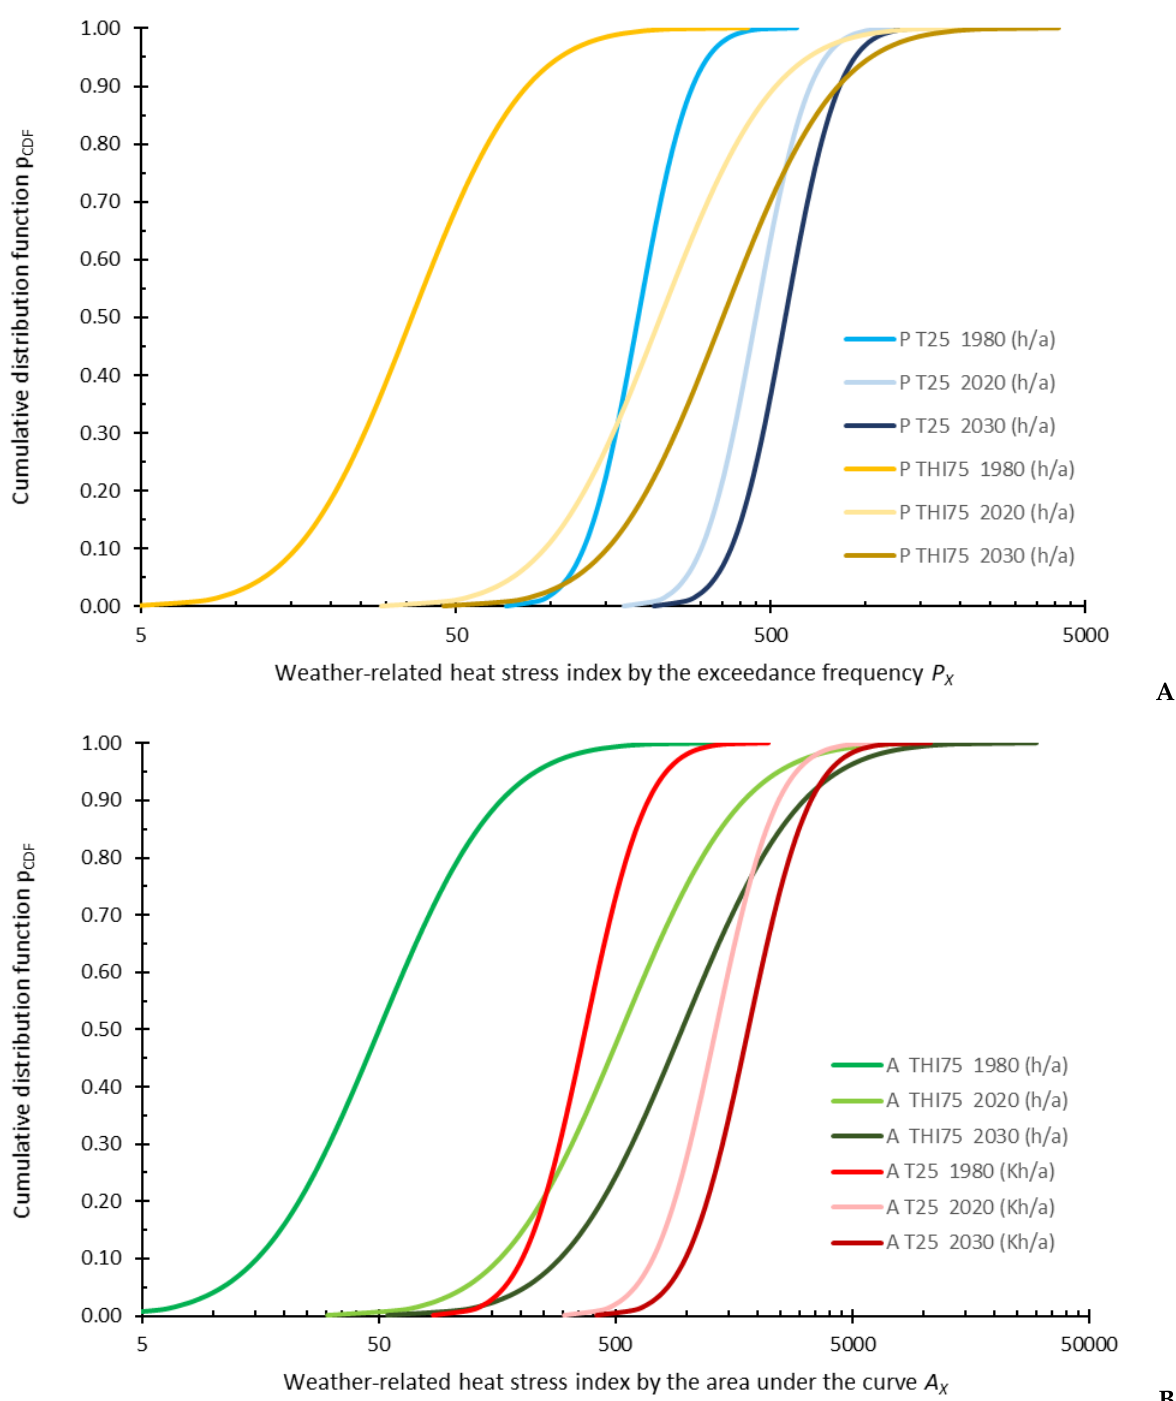
Figure 4. Likelihood for the occurrence of the weather-related heat stress indices I EXT = [P T25 , A T25 , P THI75 , A THI75 ] shown by the cumulative distribution function (CDF) of a log-normal distribution for t = 1980 (dark color), t = 2020 (light color), and t = 2030 (very dark color) for the exceedance frequency P T25 , and P THI75 (panel A ) and the area under the curve A T25 , and A THI75 (panel B ).